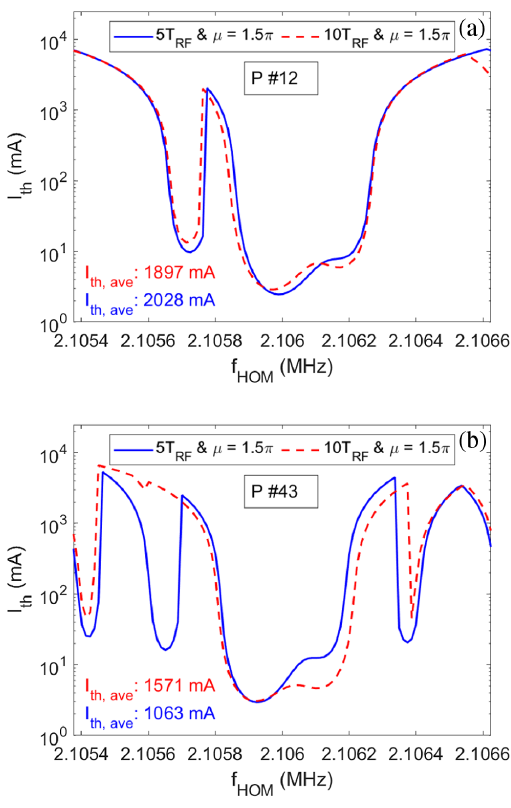
FIG. 9. Threshold currents as function of HOM frequency pattern number 12 and 43 at two bunch spacings. In (a) they similar and in (b) different threshold currents.